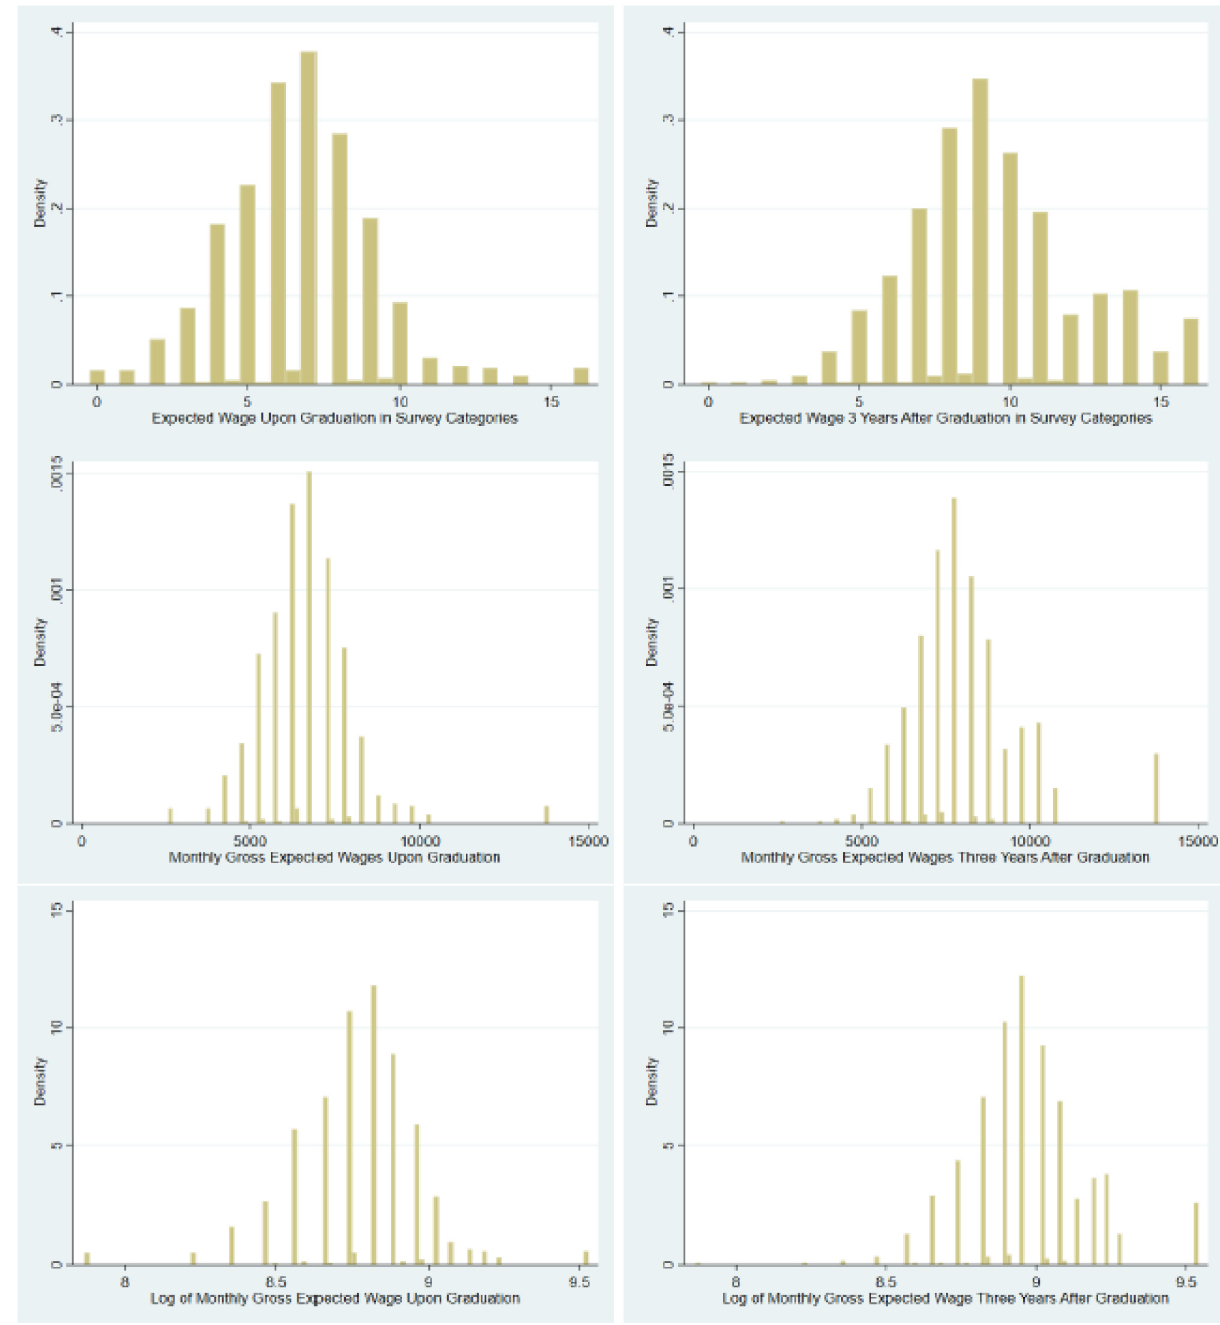
Fig 1. Histograms of expected wages in own